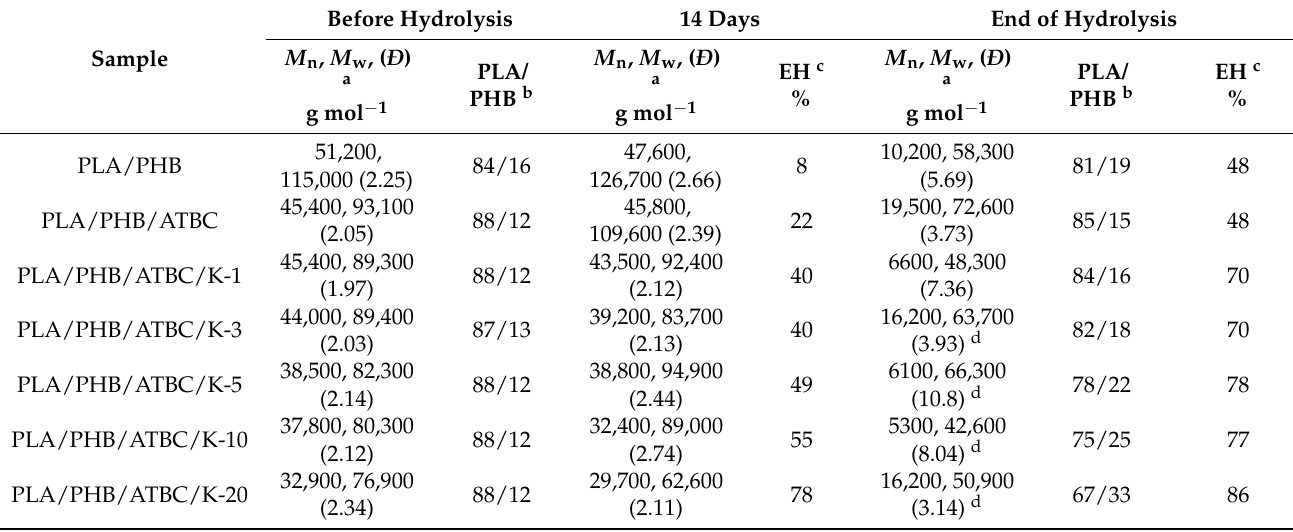
Table 3. Molecular characteristics and PLA/PHB ratio of PLA/PHB/ATBC blend and its keratin composites with different